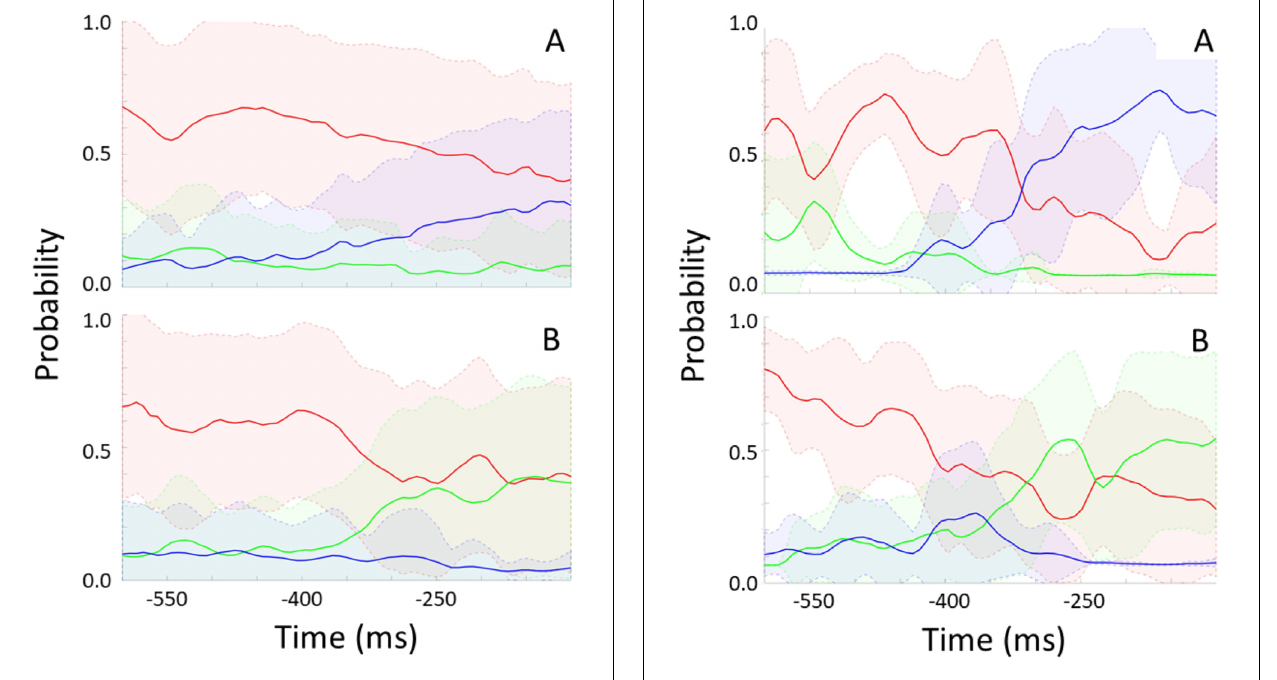
FIGURE 7 | Modeled probability for no rotation (red), rightward rotation (blue), and leftward rotation (green) over time preceding rightward rotation (A) and leftward rotation (B) for one participant. This participant produced eight rightward head rotations in the test data [i.e., (A) represents eight rightward rotations] and 12 leftward rotations [i.e., (B) represents 12 leftward rotations]. Shaded areas represent standard